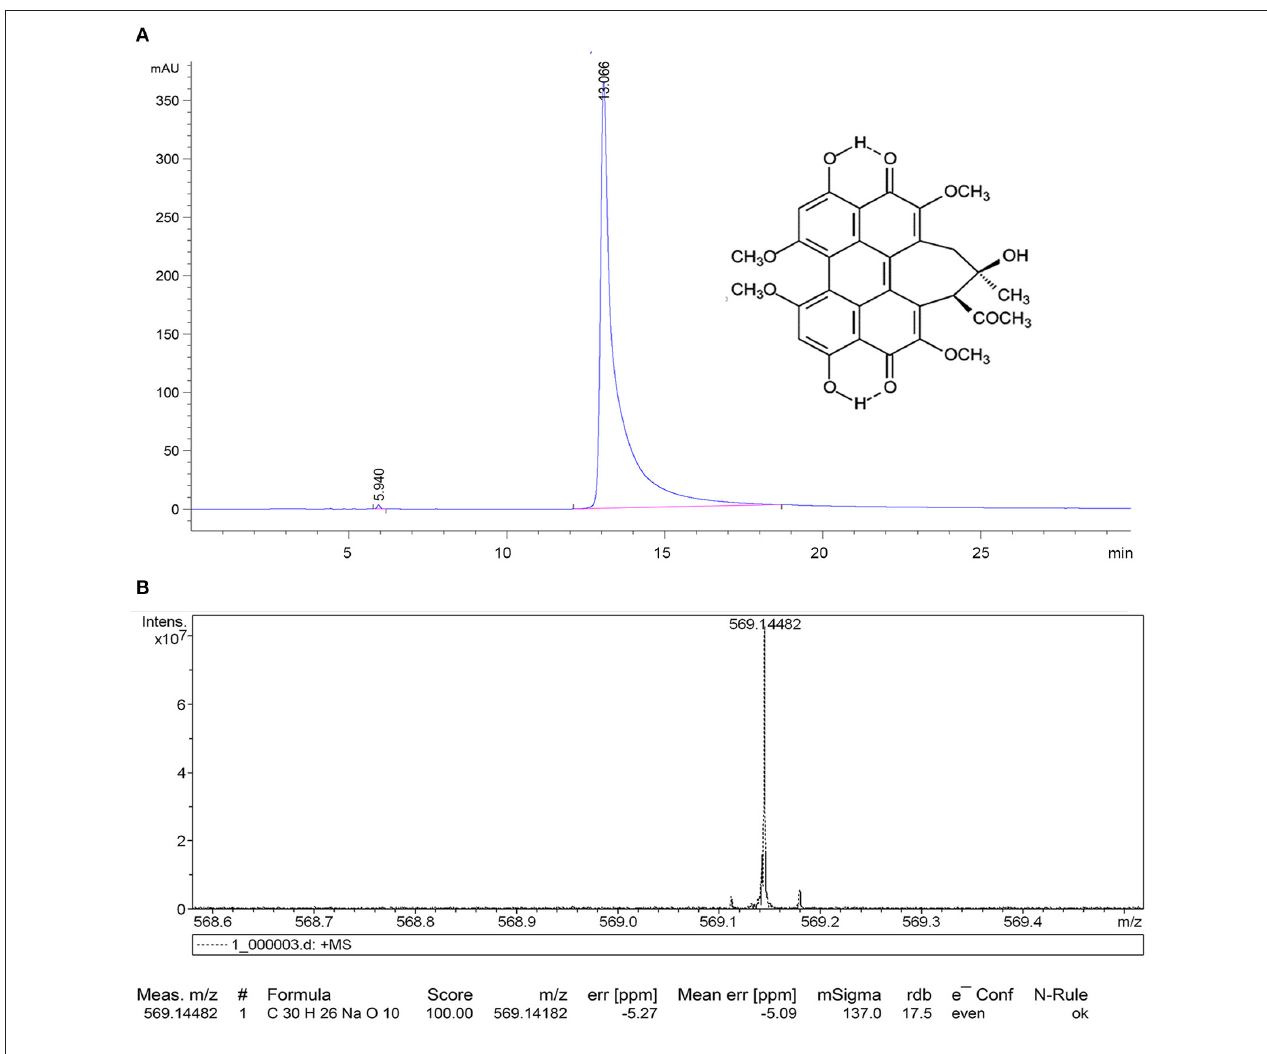
FIGURE 2 | HPLC spectrum (A) , HRMS (B) of hypocrellin